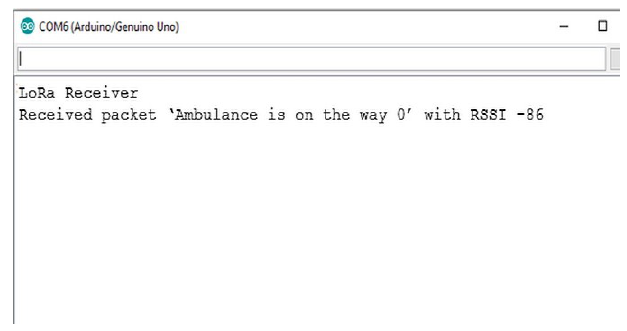
Fig. 8. LoRa receiver output display on Arduino IDE The LCD screen will display the message received as shown in fig. 9.